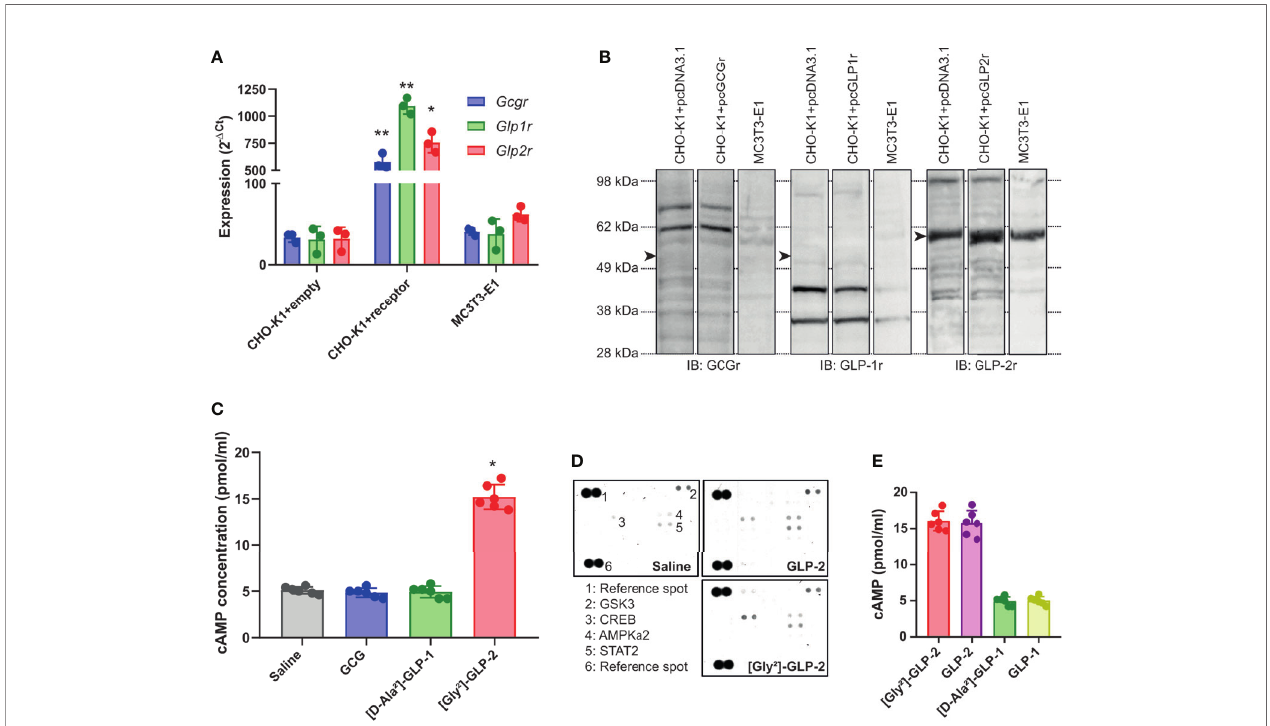
FIGURE 1 | Expression and activation of proglucagon-derived peptide receptors in murine osteoblasts. (A) Relative expression of glucagon receptor ( Gcgr ), glucagon-like peptide-1 receptor ( Glp1r ), and glucagon-like peptide-2 receptor ( Glp2r ) was investigated by qPCR. CHO-K1 cells transfected with the empty pcDNA3.1 vector was used as negative control. CHO-K1 cells transfected with the pcDNA 3.1 vector encoding the Gcgr , Glp1r , or Glp2r sequence were used as positive control. Expression in MC3T3-E1 cells was used to assess expression in osteoblast cells. (B) Presence of GCGr, GLP-1r, and GLP-2r was determined by Western blot with commercially available antibodies. Arrowheads point out at the theoretical location of receptor. (C) Intracellular levels of cAMP were determined in MC3T3-E1 cells 45 min after treatment with 50 pM of GCG, [D-Ala²]-GLP-1, or [Gly²]-GLP-2. (D) Phospho-proteome array in MC3T3-E1 cells treated with either saline or 50 pM of GLP-2 or its long-lasting analog [Gly²]-GLP-2. (E) Intracellular levels of cAMP were determined in MC3T3-E1 cells 45 min after treatment with 50 pM of GLP-2 or [Gly²]-GLP-2. * p < 0.05 and ** p < 0.01 vs. saline-treated